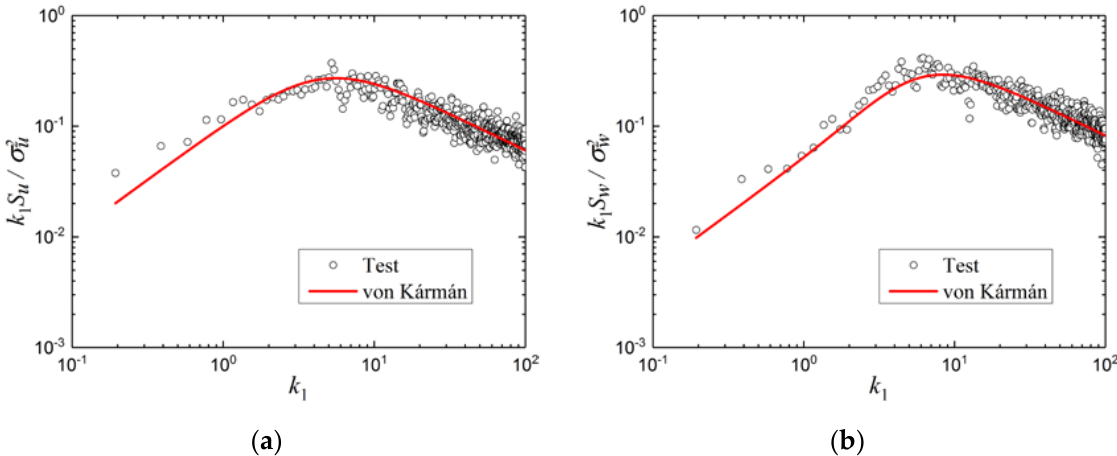
Figure 6. Longitudinal and vertical turbulence spectra in XNJD-1 spire turbulence field. ( a ) Longitudinal; ( b ) vertical.